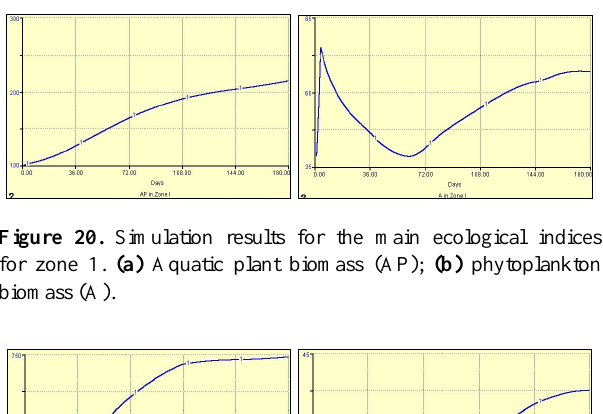
Fig. 23. Simulation results of the main ecological indexes at zone IV